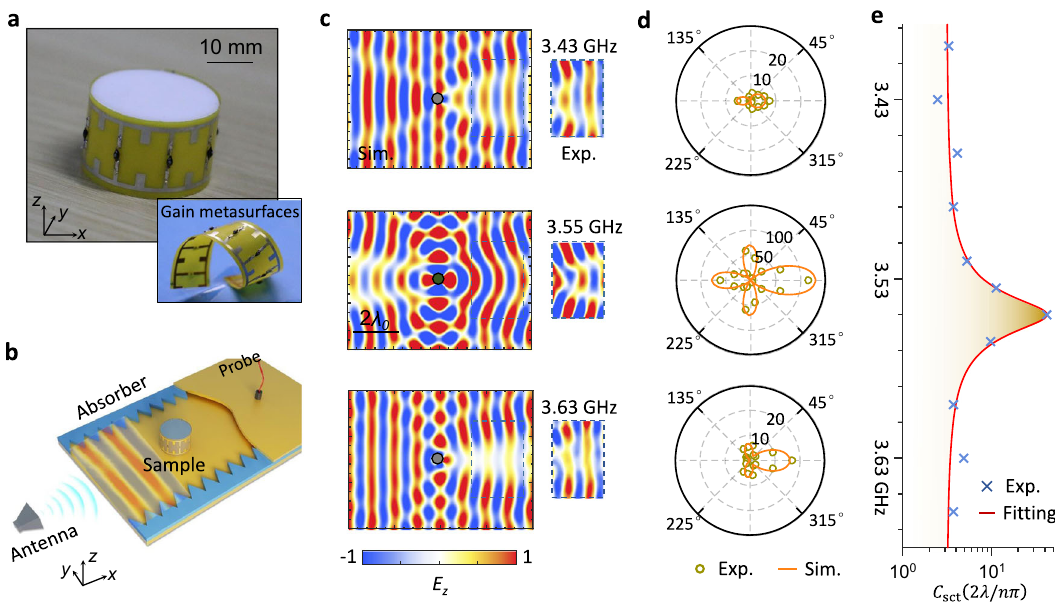
Fig. 4 | Observation of the single-channel superscatterer in the frequency domain. a Photograph of the fabricated single-channel superscatterer and gain metasurfaces. b Acutawayviewoftheexperimentalsetup.Tomimica2Dcase,the designed sample is located at the center of the two planar metallic waveguides separated by absorption layers with a distance of h =18mm, which is the same as the height of the single-channel superscatterer. Within the frequency range of interest, the designed waveguide only supports the fundamental TM 0 mode. A